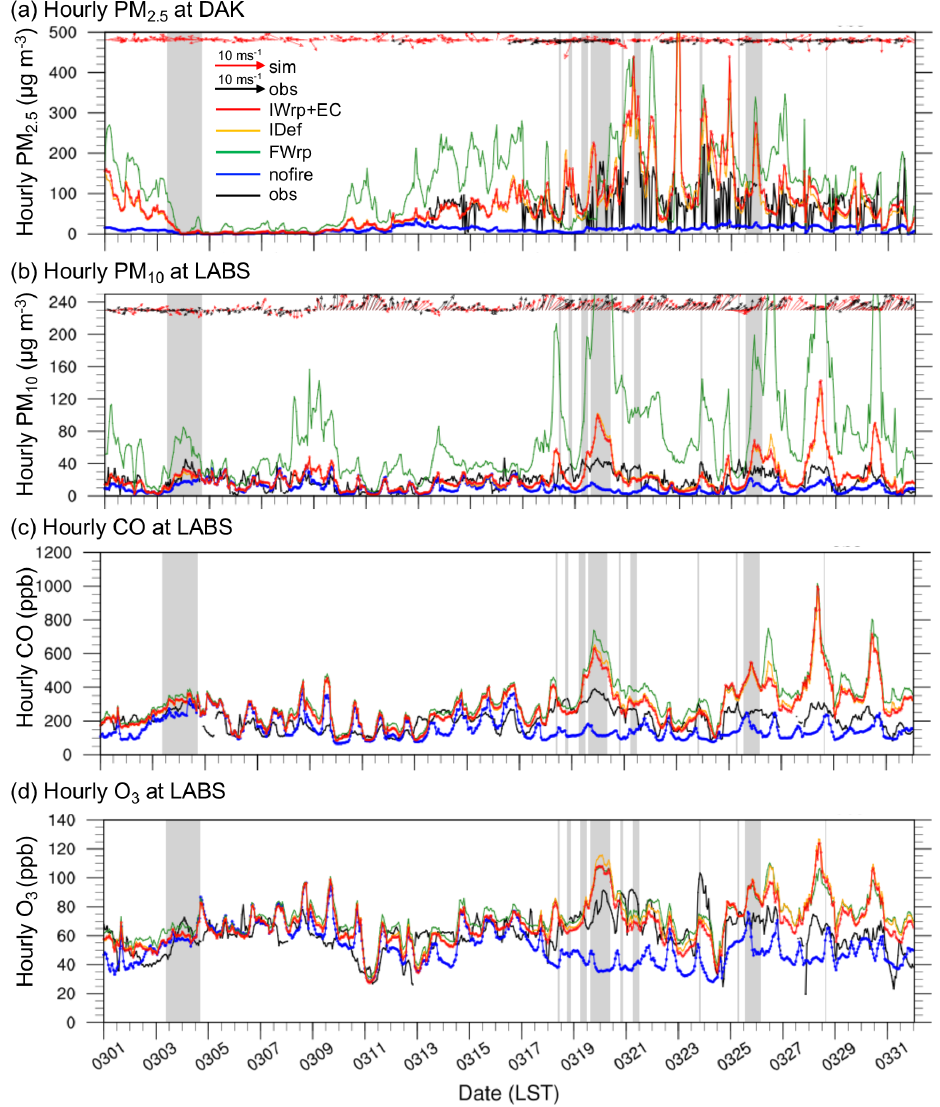
Figure 3. Comparison of PLMRIM (observation (black), nofire (blue), FWrp (green), IDef (orange), IWrp + EC (red)) of (a) hourly wind field and PM 2 . 5 at DAK and (b–d) hourly wind field and (b) PM 10 , (c) CO and (d) O 3 at LABS in March 2013; gray shade highlights the high-pollution hour at LABS (CO > 300ppb, PM 10 > 35µgm − 3 ). Wind field for observation (black) and simulation (red) is shown in vector